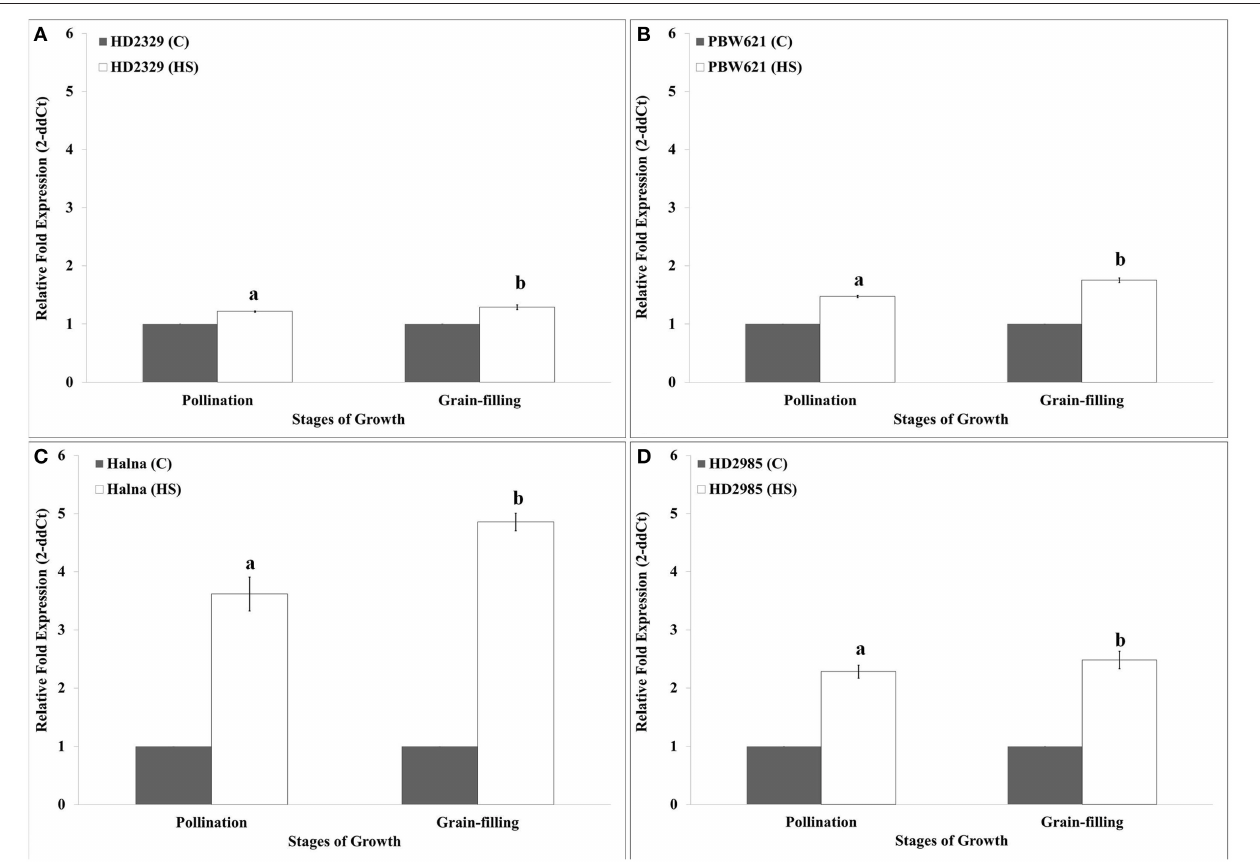
FIGURE 5 | Expression profiling of RuBisCo activase ( TaRca1 ) in wheat during pollination and grain-filling stages under control (C) and heat stress (HS) conditions. (A) HD2329 (C and HS), (B) PBW621(C and HS), (C) Halna (C and HS), (D) HD2985 (C and HS); C − 22 ± 3 ◦ , heat stress − 42 ◦ C for 2 h; β -actin gene (accession no. AF282624) was used as endogenous control for normalizing the C t value; Relative expression was calculated by Pfaffl method (Pfaffl et al., 2002); vertical bars indicate SE ( n = 3